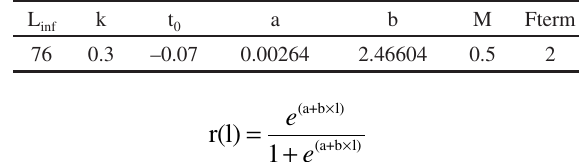
Table 1. – Parameters used for the pseudo-cohort analysis for red shrimp females. Parameters of the Von Bertalanffy relationship , k, t ) are from Sardà and Demestre (1987); parameters of the (L inf 0 length-weight relationship (a, b) are from Demestre (1990); natural mortality (M) is from Demestre and Martín (1993). Fterm is the terminal fishing mortality for the pseudo-cohort analysis, assumed as in Demestre and Lleonart